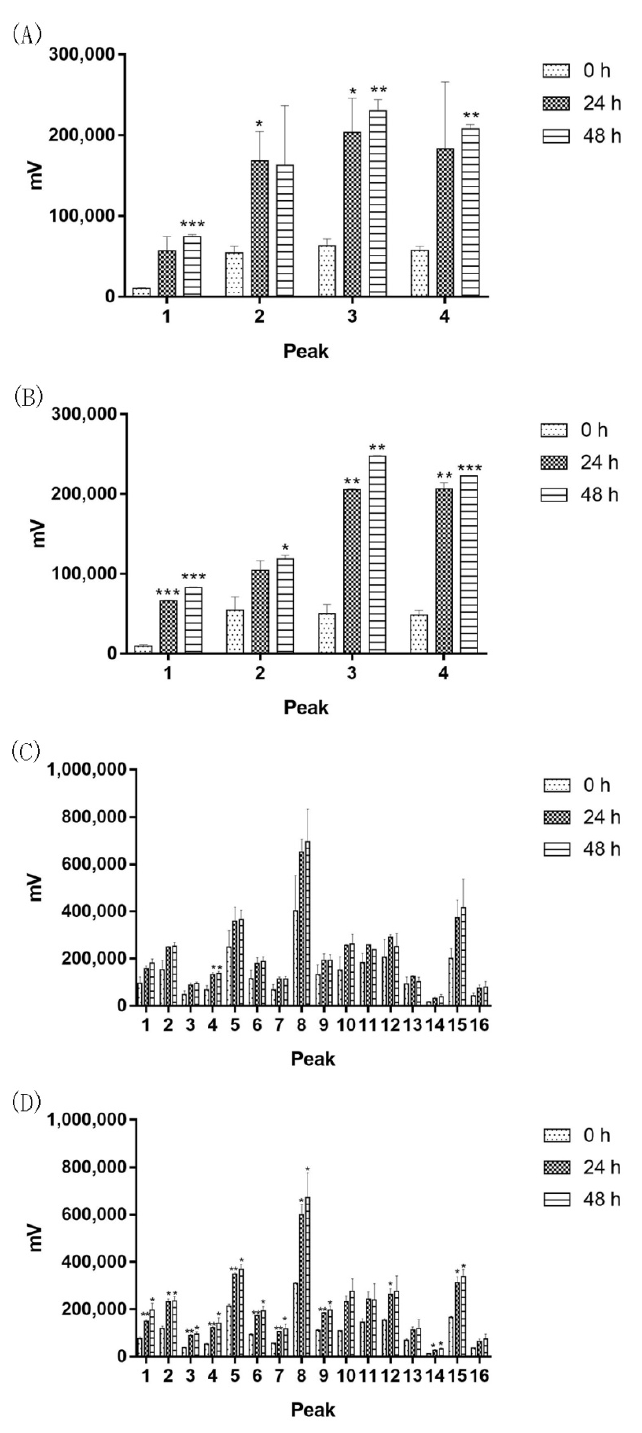
Figure 5. Effect of saprophytic Bacilli on Dalbergiaod orifera T. Chen and Zanthoxylum bungeanum Maxim. ( A ) and ( B ): Bs-2 and Bs-4 were separately put in test tubes with liquid LB medium and Dalbergiaod orifera T. Chenpowder, and then the mixture was incubated. Samples were taken at 0 h, 24 h and 48 h, and then filtered for HPLC analysis. ( C ) and ( D ): Bs-2 and Bs-4 were separately put in test tubes with liquid LB medium and Zanthoxylum bungeanum Maxim powder, and then the mixture was incubated. Samples were taken at 0 h, 24 h and 48 h, and then filtered for HPLC analysis. Values are expressed as mean ± SEM, * p < 0.05, ** p < 0.001, and *** p < 0.0001 vs. control.